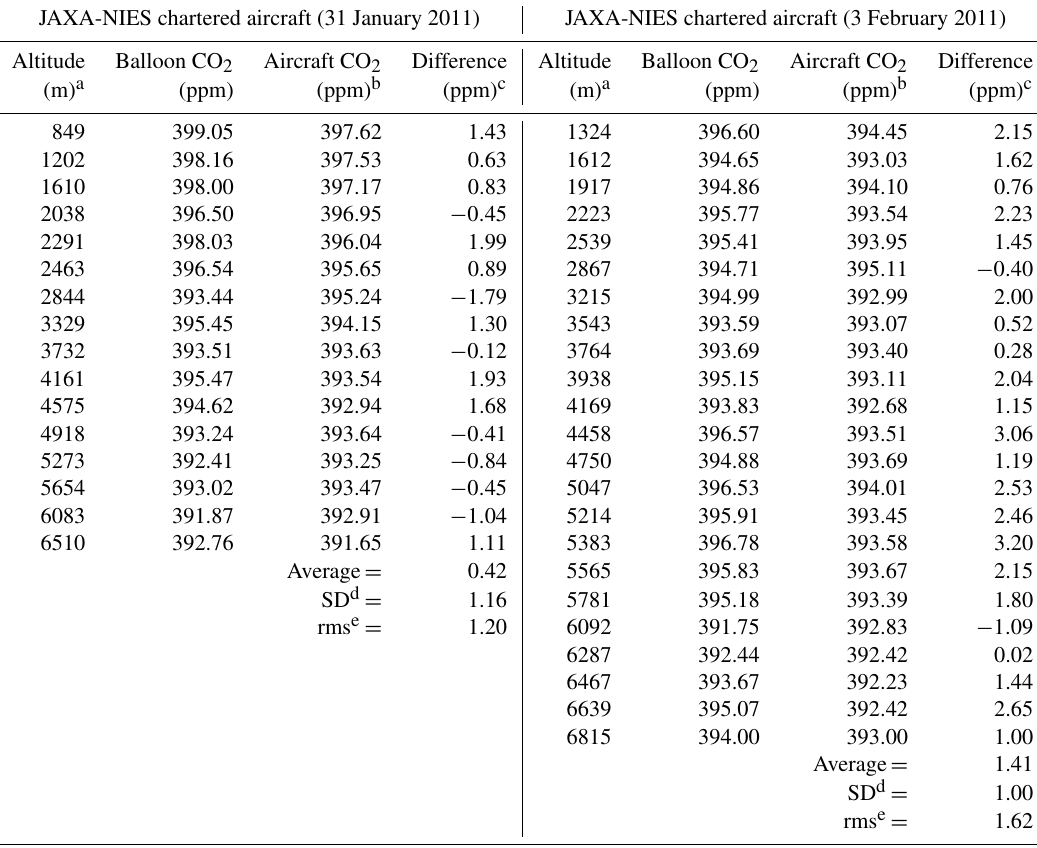
Table 2. Comparisons of the CO 2 mole fractions between the balloon CO 2 sonde and NIES/JAXA chartered aircraft measurements on 31 January and 3 February